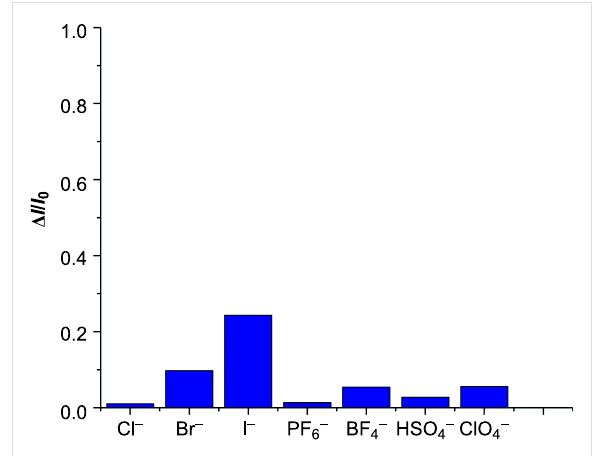
Figure 6: Column diagram of fluorescence enhancement efficiency of 4 (2.5 × 10 − 5 M) in the presence of 20 equivalents of Cl − , Br − , I − , PF 6 −